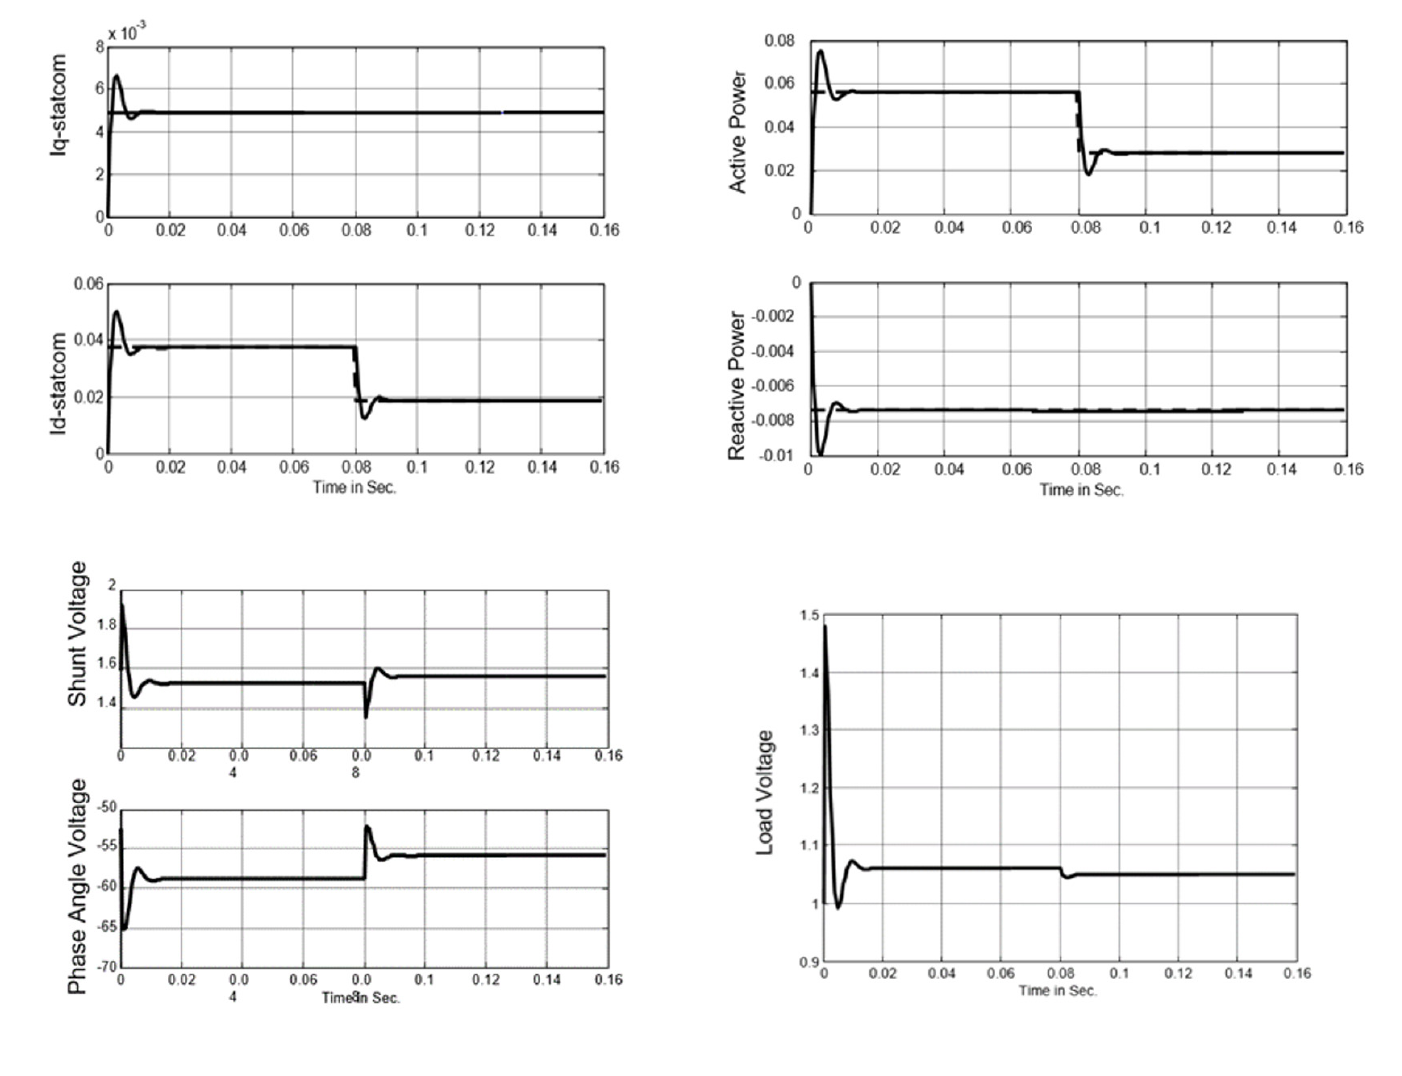
Figure 8. The transient performance of the STATCOM in case of active power variation with